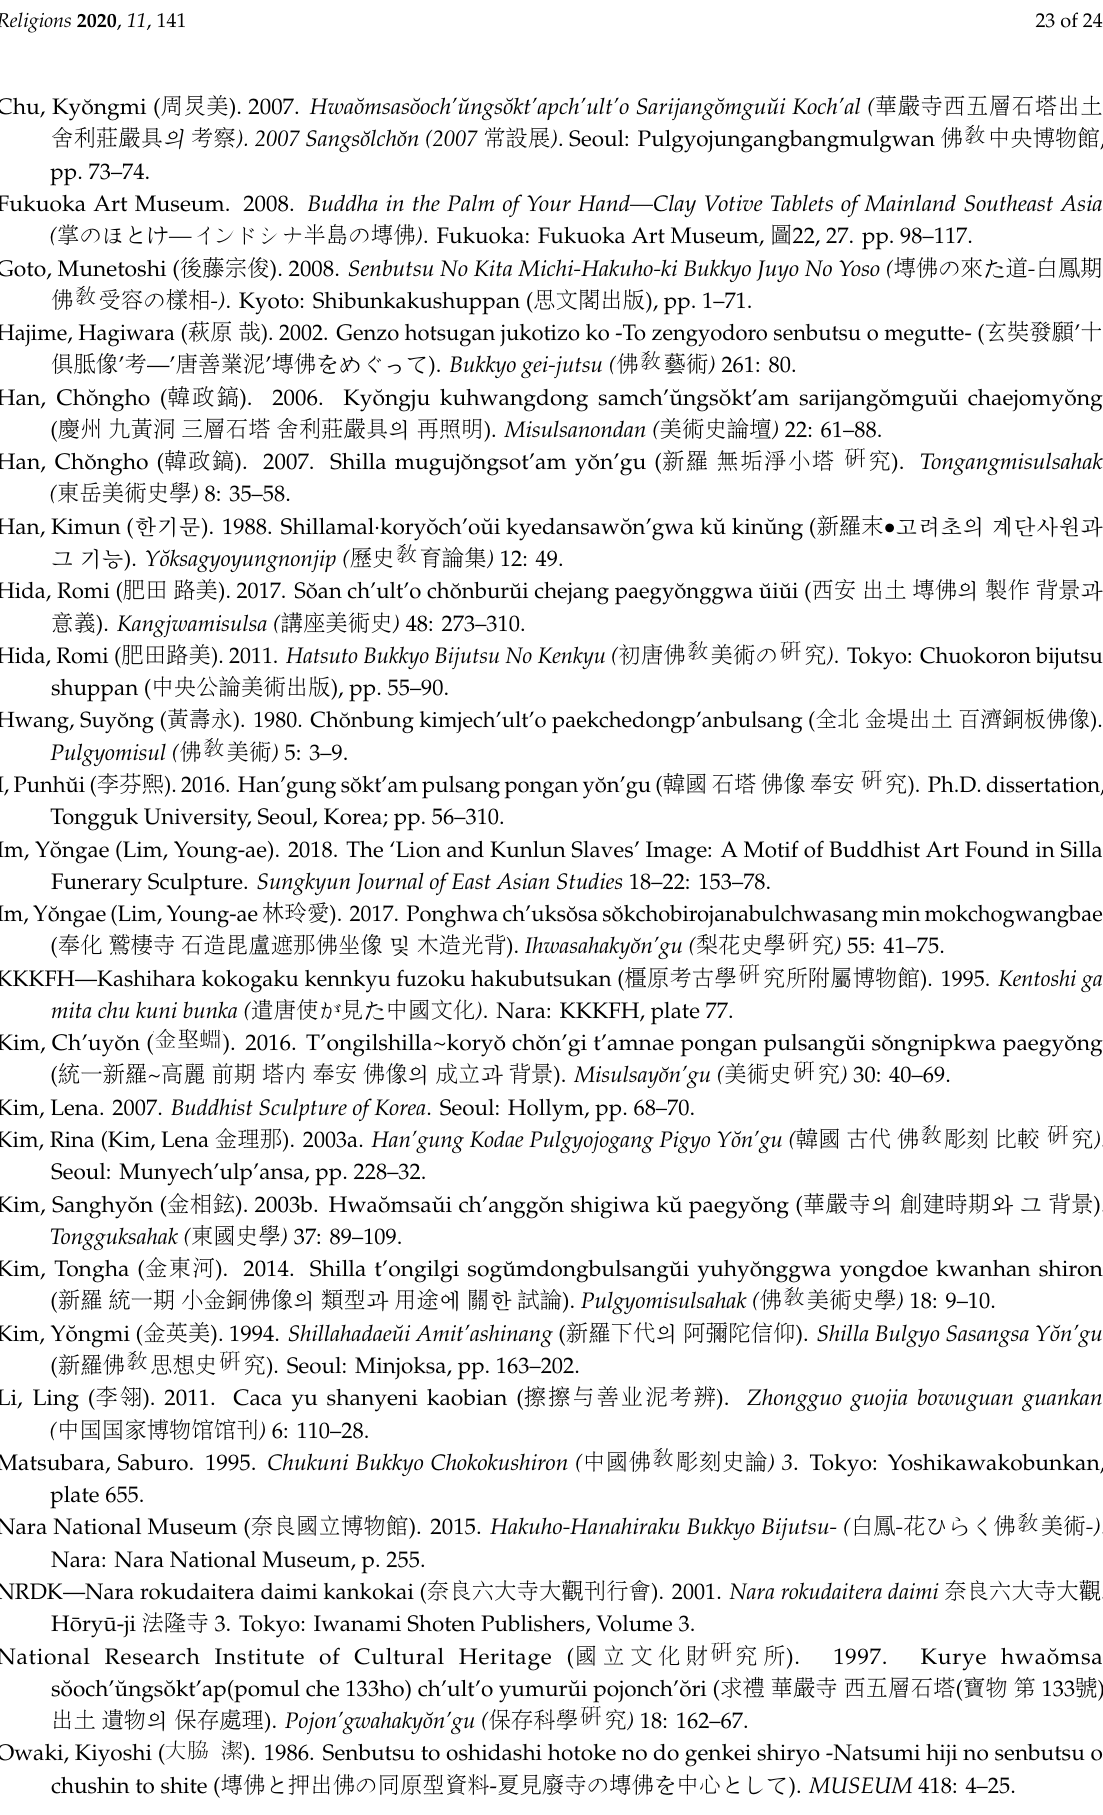
Figure 20. Clay Buddha, Pagan period, 12th–13th centuries, 9.6 × 7.1 cm, Myanmar [Source: (Fukuoka Art Museum 2008, cover picture)].